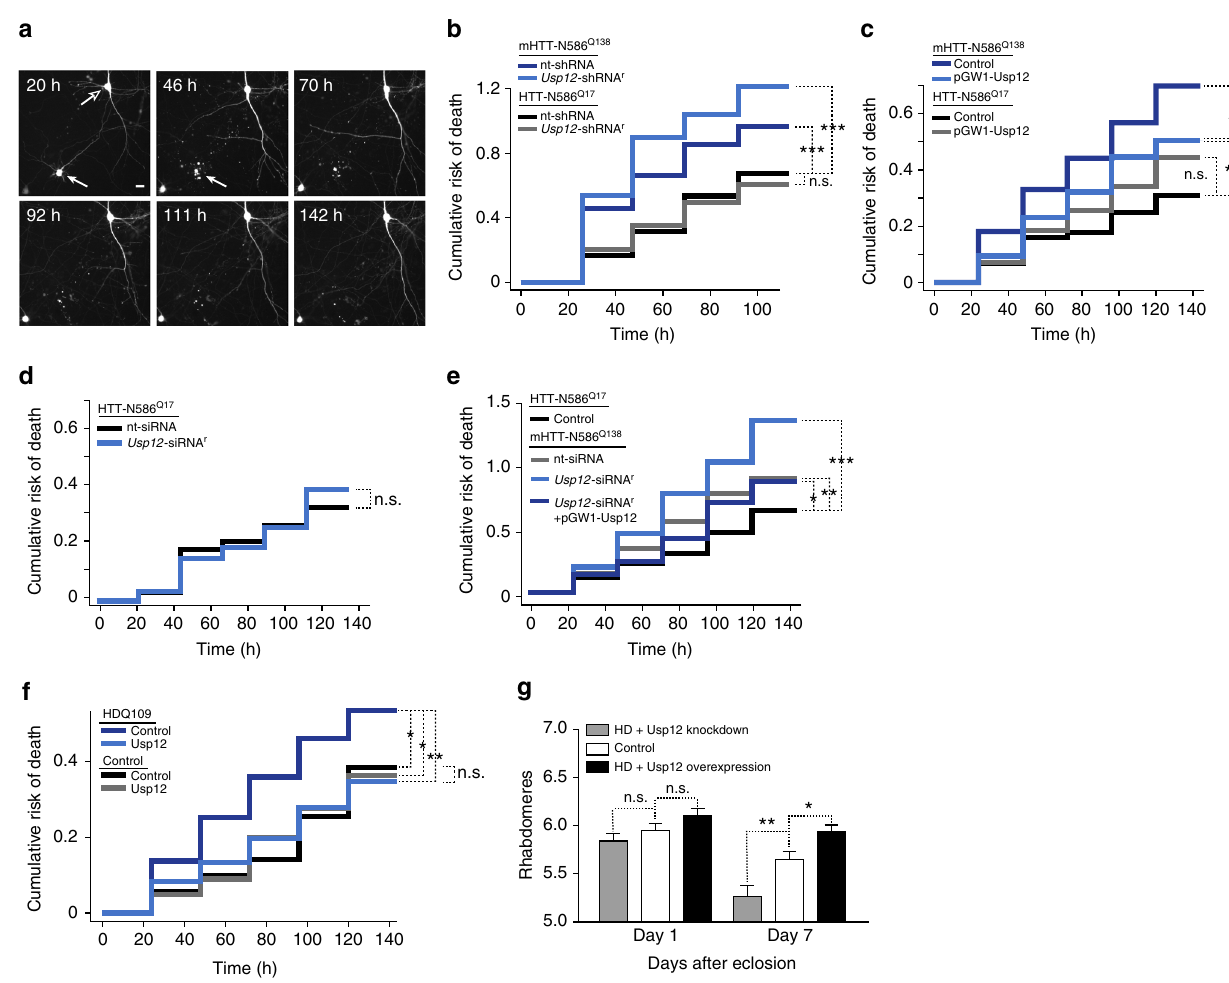
Fig. 1 Usp12 is a modi fi er of mHTT toxicity in vitro and in vivo. a Representative images of primary neurons expressing RFP captured at the indicated time intervals after transfection. Expression of RFP is used as a morphological marker to track the survival of neurons by a robotic microscope. Examples of neurons that survived the entire time course of observation (empty arrowhead) or died by 46 h post transfection ( fi lled arrowhead) are shown (scale bar = 20 µ m). b – e Cumulative risk of death plots of primary rodent cortical neurons. The cumulative risk of neuron death is plotted against time (h) for each group of neurons transfected with the indicated plasmids. Cox proportional hazards analysis was used to estimate the relative risk of death or hazard ratio (HR), and the p value was determined with the log rank test (* p < 0.05, ** p < 0.01, *** p < 0.001, n.s. not signi fi cant) (for statistical information, see Supplementary Tables 1, 2, and 3). f Survival analysis of human neurons differentiated from patient-derived iPSCs (unaffected individual, control; HD patient, HDQ109) transfected with MAP2-RFP (morphology marker), and Usp12 or control vectors (statistical information is summarized in Supplementary Table 3). g Quanti fi cation of average rhabdomeres per ommatidium at day 1 and day 7 after eclosion. Two-way ANOVA: genotype effects, p < 0.0001; age effects, p < 0.0001, n = 8 – 10 fl ies per genotype. Multiple comparisons analysis: day 1 genotype analysis for control vs. Usp12 knockdown ( p = 0.7020) and control vs. Usp12 overexpression ( p = 0.3589); day 7 genotype analysis for control vs. Usp12 knockdown ( p = 0.0041) and control vs. Usp12 overexpression ( p = 0.0270). n.s. not signi fi cant; * p < 0.05; ** p < 0.01. Two-way ANOVA with Bonferroni ’ s multiple comparisons post hoc test. Error bars represent s.e.m. Table 2). The speci fi city of the increased toxicity observed upon Usp12 knockdown was con fi rmed by overexpressing human Usp12 in neurons. Usp12 rescued the toxicity mediated by the Usp12 -siRNA r (Fig. 1e, Supplementary Table 2). We next sought to further establish the physiological relevance of Usp12 as a modi fi er of mHTT using human neurons from HD patients that express full-length mHTT under its endogenous promoter. Neurons differentiated from HD patient-derived iPSCs exhibit several features reminiscent of HD pathobiology, such as changes in gene/protein expression, the cytoskeleton, adhesion, electrophysiological properties, energy metabolism, and survi- val 24 . For this assay, we differentiated neuronal cells from an HD patient with 109 polyglutamine repeats (HDQ109) and an unaffected individual with 20 polyglutamine repeats (control). NATURE COMMUNICATIONS| (2018)9:3191|DOI: